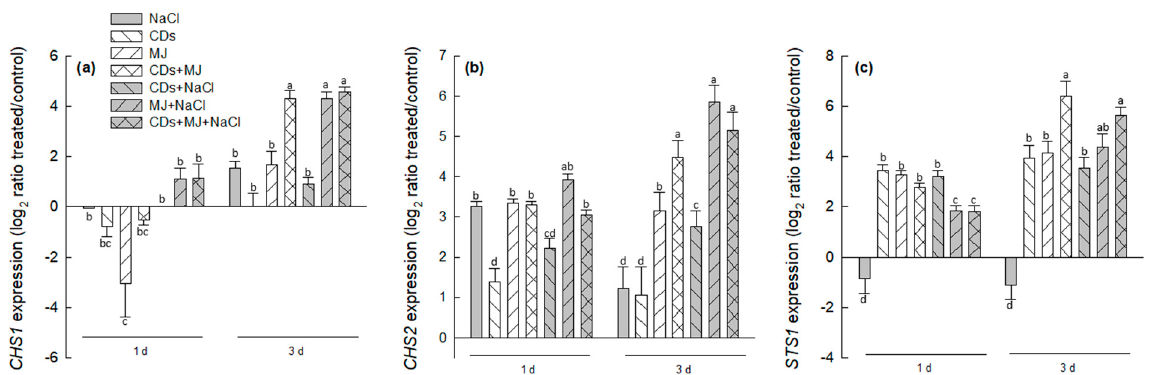
Figure 4. The effects of salt and/or elicitor treatments on the gene expression of CHS1 ( a ), CHS2 ( b ), and STS1 ( c ) analyzed by qRT-PCR. The data represent the mean ± SE of three independent replicates. Values followed by different letters are significantly different at p < 0.05 by Tukey’s HSD test.